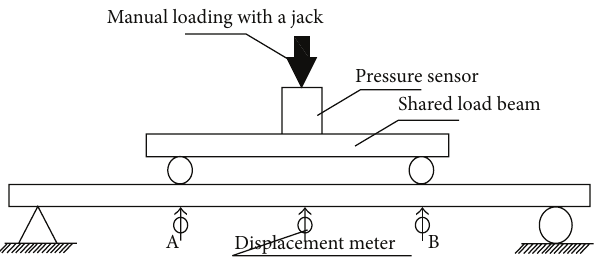
midspan section and at the locations of the force-bearing steel bars. Figure 11 shows the corresponding measuring points. The concrete strain gauges on the CFRP prestressed flat slab correspond to the locations of the longitudinal steel bars in the ordinary concrete